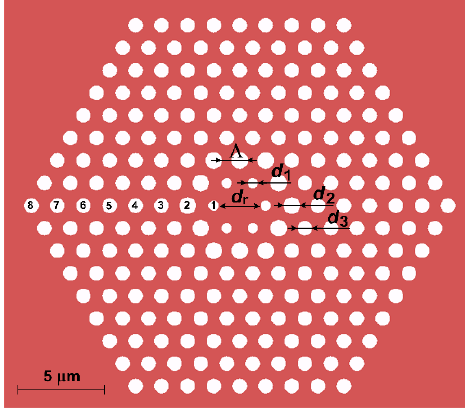
Figure 1. The schematic of the structure of the analyzed PCF. The numbers from 1 to 8 represent subsequent rows of holes surrounding the core.